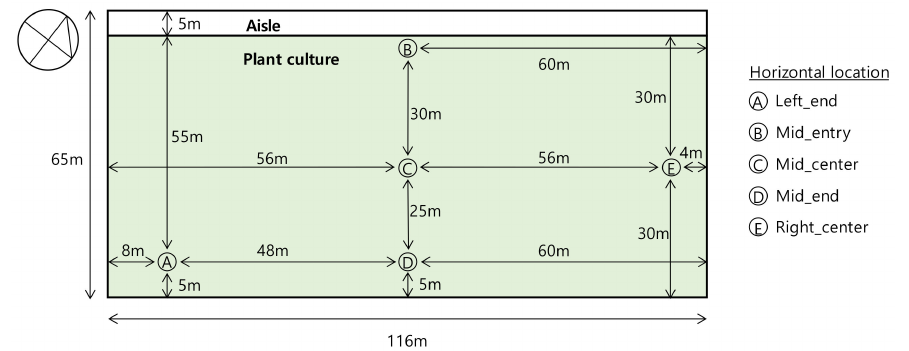
Figure 5. Schematic representing the sensor installation floor plan in the greenhouse. This pic- ture shows sensors for collecting measurements from corners, aisles, and central locations of the greenhouse to assess the representativeness of the greenhouse climate.